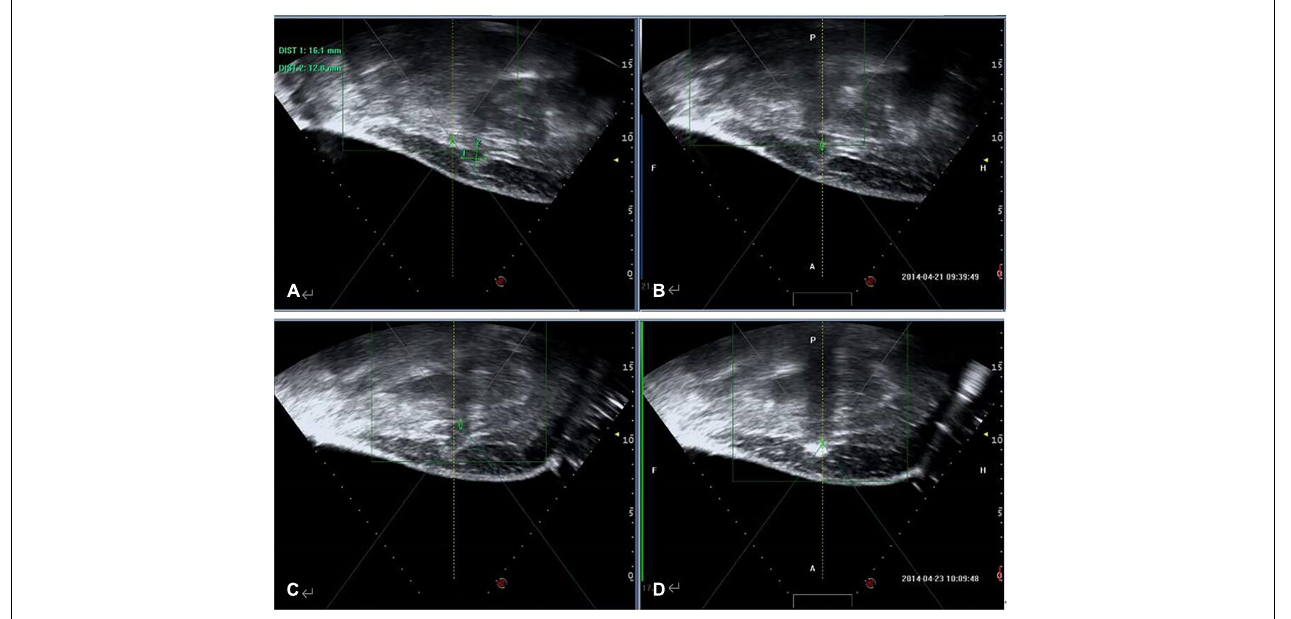
FIGURE 1 | Ultrasound imaging in a 35-year-old woman with AWE. Intraoperative ultrasound was used to measure and locate the AWE lesion. (A) Before HIFU ablation, sagittal-guided ultrasound showed a low echogenic nodule of approximately 16.1 × 12.8 mm in the right subcutaneous muscle layer of the abdominal wall incision (white arrow). (B) Focused ultrasound focus localization was displayed before ablation (white arrow). (C) During the operation, ultrasound energy of fixed-point emission (white arrow). (D) The focus position showed a massive hyperechoic change (white arrow), but there was no significant echo change in the superficial tissue of the lesion. TABLE 3 | Comparison of AWE lesion size between MRI and color Doppler ultrasound before HIFU treatment. Project Ultrasound MRI P value Maximum radius of lesion